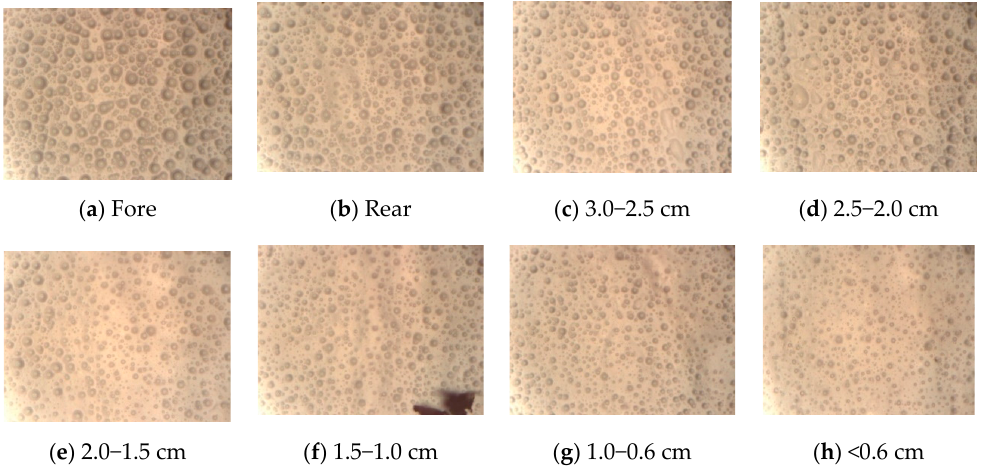
Figure 10. Particle size test diagram. ( a ) is the droplet at the entrance of the empty pipe; ( b ) is the droplet at the exit of the empty pipe; ( c ) is the exit droplet with a particle size of 3.0 − 2.5 cm; ( d ) is the exit droplet with a particle size of 2.5 − 2.0 cm; ( e ) is the exit droplet with a particle size of 2.0 − 1.5 cm; ( f ) is the exit droplet with a particle size of 1.5 − 1.0 cm; ( g ) is the exit droplet with a particle size of 1.0 − 0.6 cm; and ( h ) is the exit droplet with a particle size of <0.6 cm. Use Image-Pro Plus software to count the aerosol particle size, as shown in Figure 10.